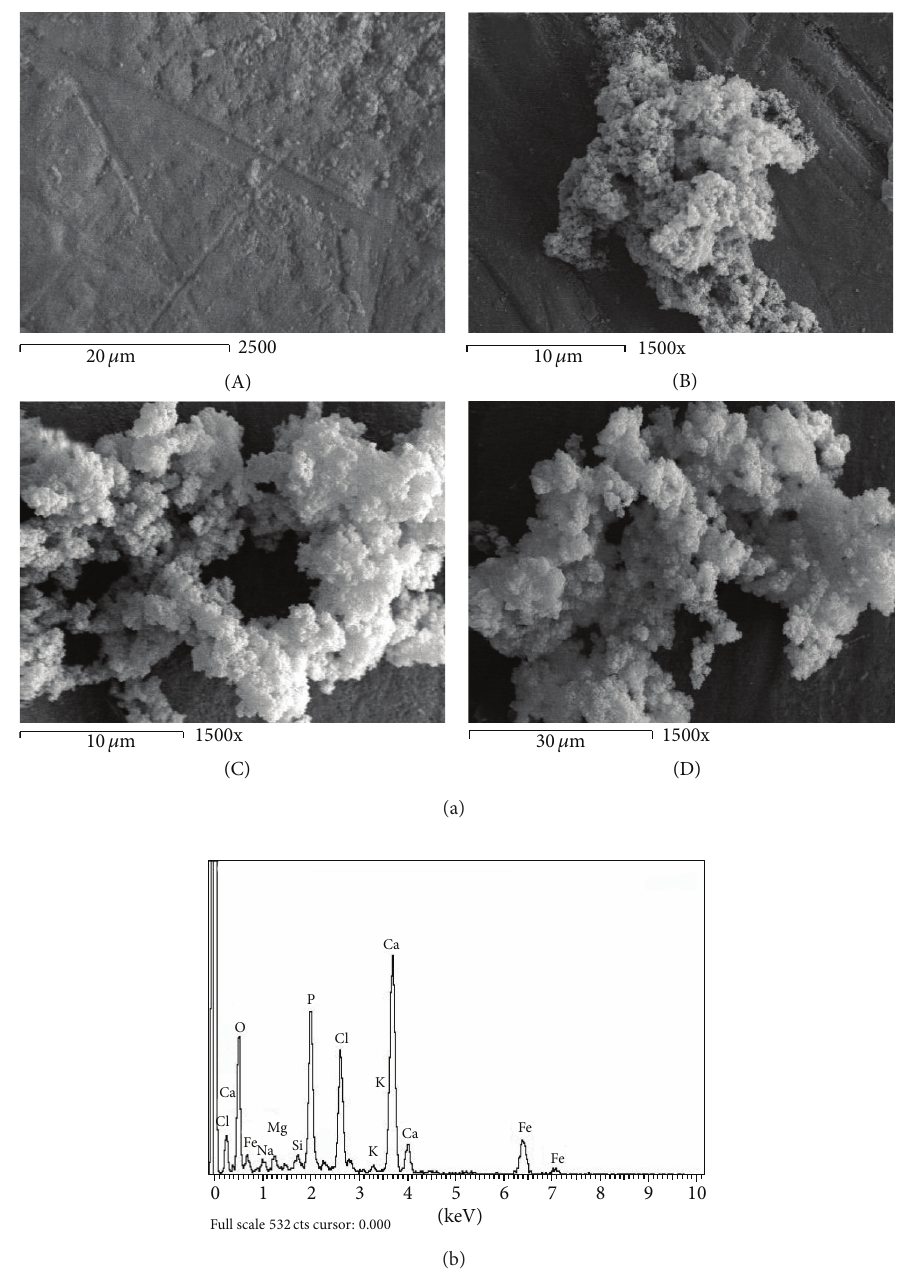
Figure 2: (a) SEM micrograph of Ca-doped glass ceramics (A) before, (B) after 1 week, (C) after 2 weeks, and (D) after 4 weeks of immersion in SBF. (b) EDAX of Ca-doped glass ceramics after 4-week immersion in SBF.